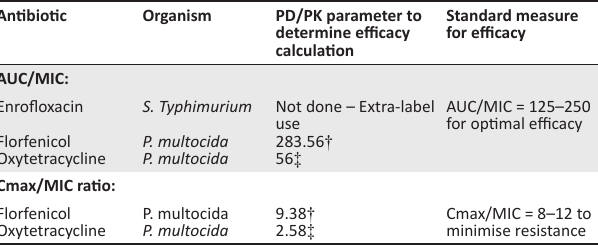
Florfenicol Pasteurella